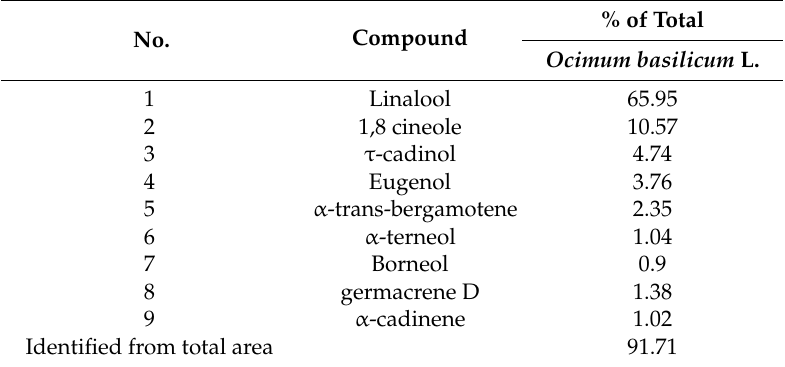
Table 1. Chemical composition of Ocimum basilicum L. oils from southern Romania. No. Compound